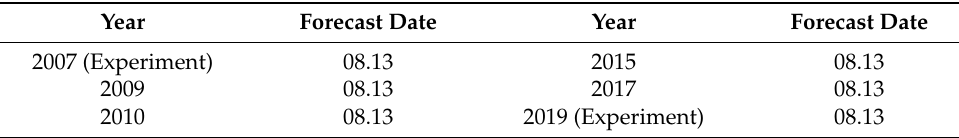
Table 1. Study Area Demand Forecast Data